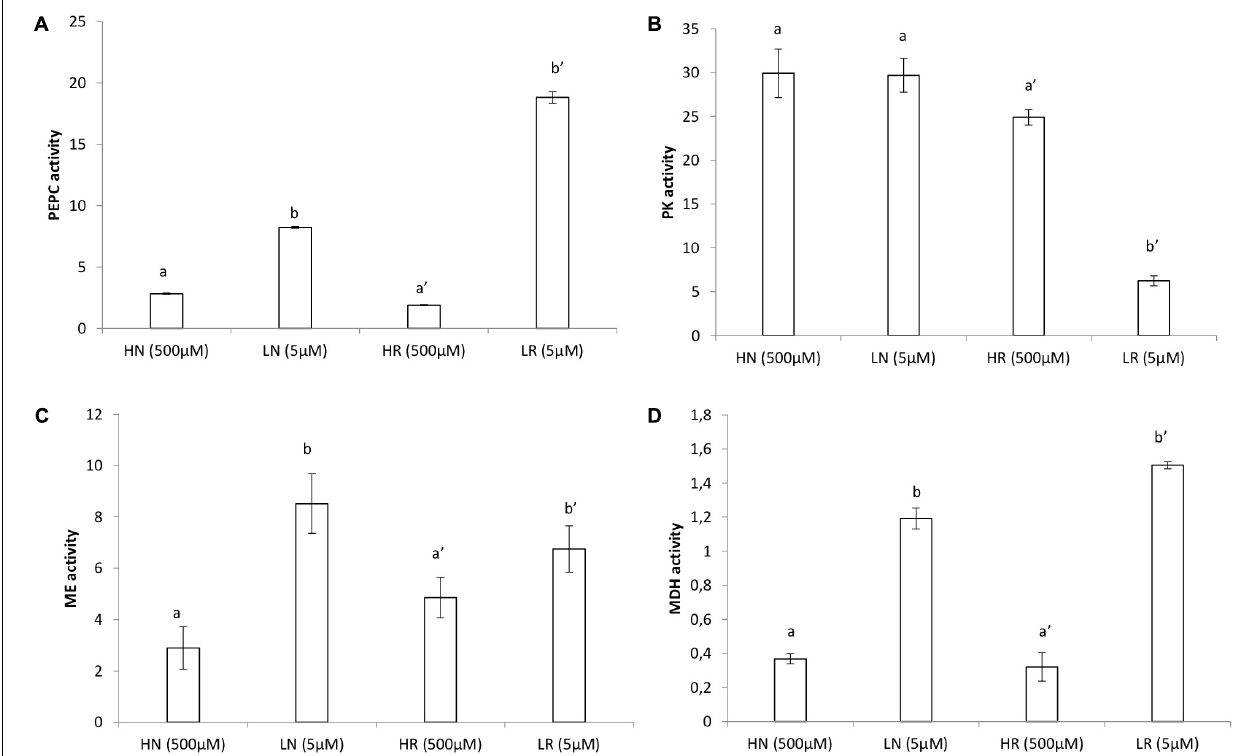
FIGURE 3 | Enzyme activities ( µ mol.min − 1 .g − 1 FW) in roots and nodules of V. divaricata grown under high phosphate (500 µ M) and low phosphate (5 µ M) conditions (A) PEPC, (B) PK, (C) ME, (D) MDH. HN (high P nodules), LN (low P nodules, HR (high P roots), and LR (low P roots are compared). Values of four replicates are presented as means ± SE. Different letters indicate significant differences between treatments ( P ≤ 0.05).